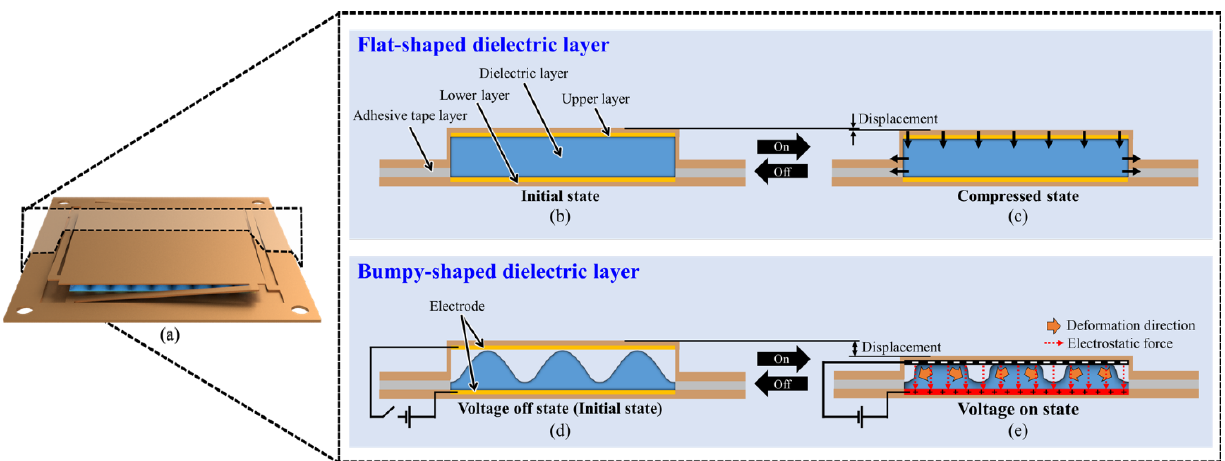
Figure 2. ( a ) Fabricated vibrotactile actuator; operating principles of the proposed actuator based on ( b , c ) a flat-shaped dielectric layer or ( d , e ) a bumpy-shaped dielectric layer.